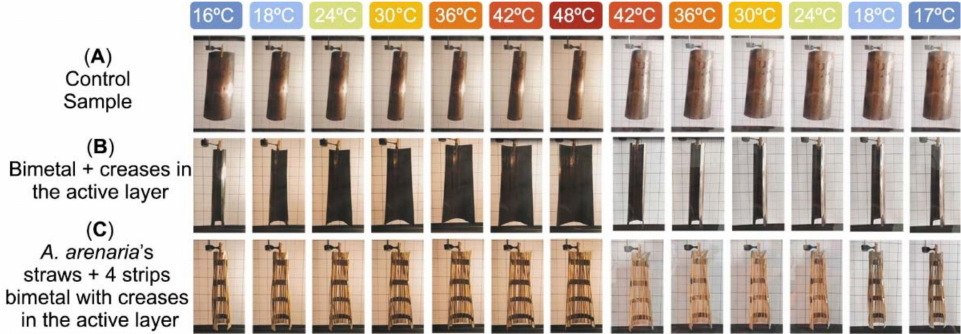
Figure 15. Experiment with 100 × 150 mm samples ( A – C ). Source: